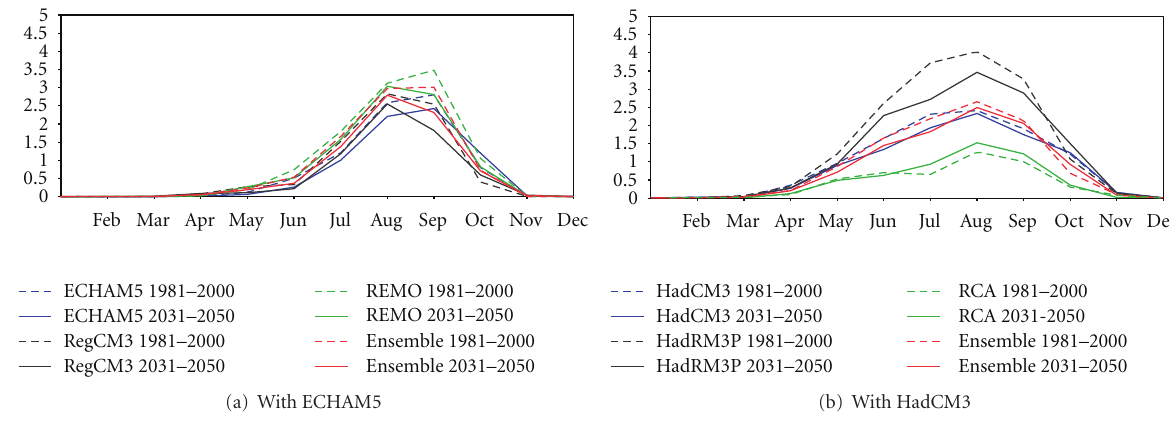
Figure 12: Present-day and future annual cycles of precipitation (in mm/day) over Western Sahel from, GCMs (ECHAM5 and HadCM3), RCMs (RegCM3, REMO, RCA, and HadRM3P), and the ensemble mean of RCMs driven by ECHAM5 and HadRM3P. The present day is represented by dashed lines and future by solid lines.